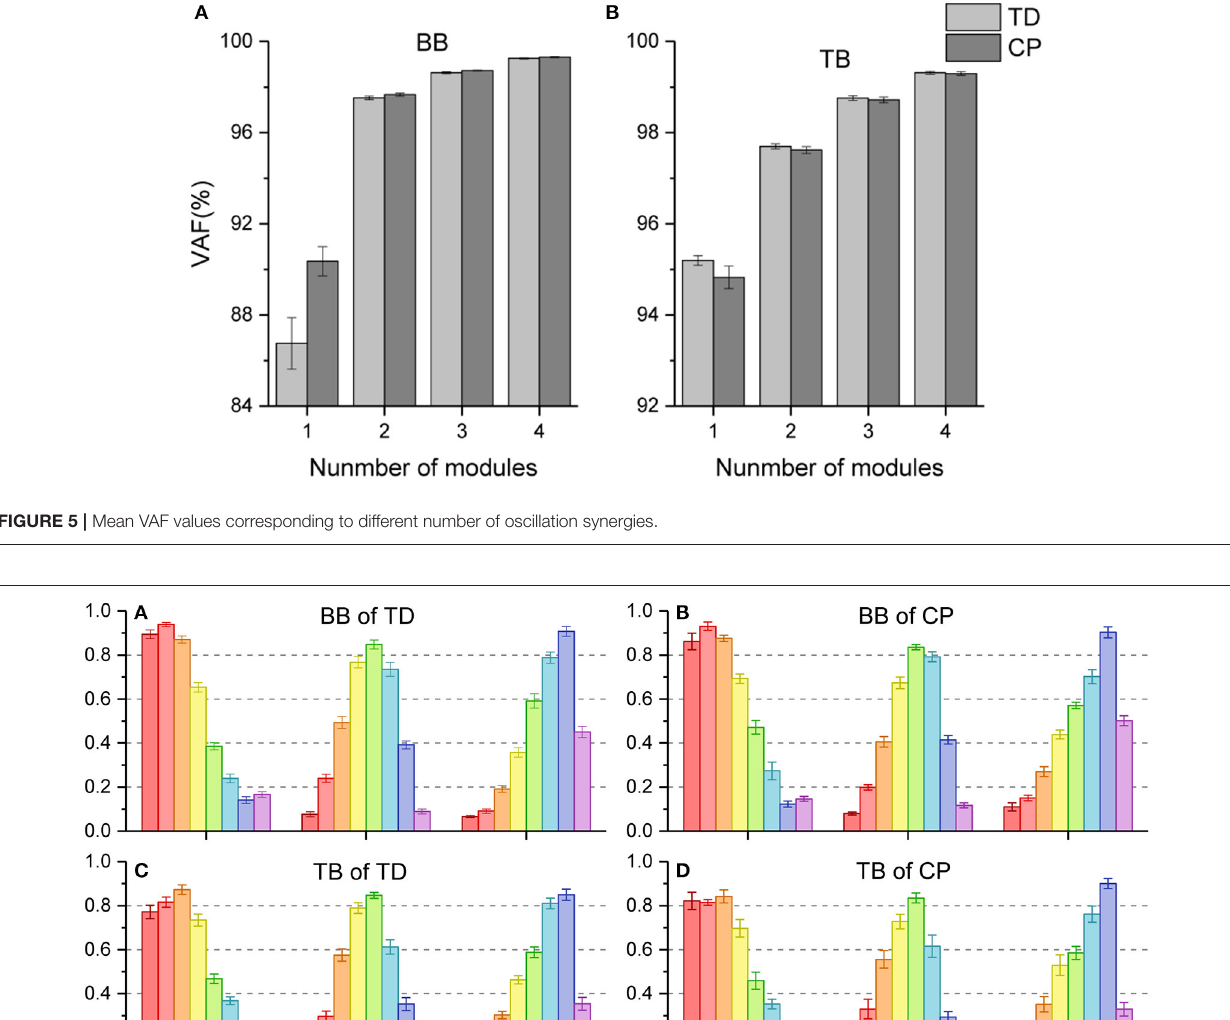
( Figure 8D , p = 0.007). During the BSP ( p = 0.007) and BRP crawling ( p = 0.006), CP maintained a high level